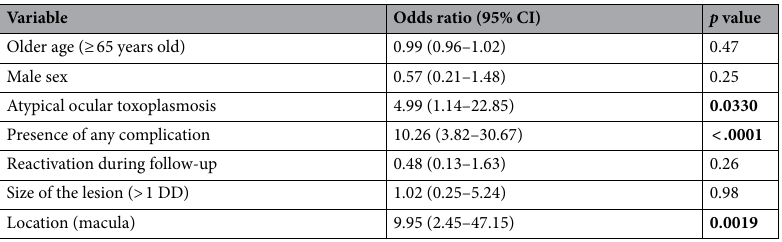
Table 4. Multivariate binary logistic regression of variables associated with poor visual prognosis in eyes with active ocular toxoplasmosis at presentation (final best-corrected visual acuity ≤ 20/200; n = 133 eyes). DD = disc-diameter; CI = confidence interval.